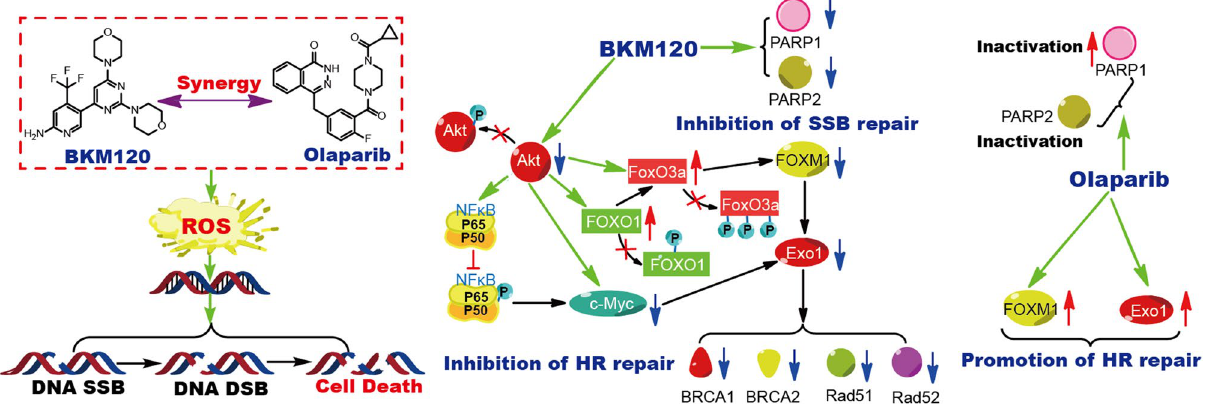
Figure 8. Mechanism for the synergistic effects of BKM120 and olaparib on the death of MDA-MB-231 cells. BKM120 directly induces DNA damage through increasing cellular ROS. Meanwhile, BKM120 downregulates the expression of PARP1 and PARP2 to synergy the inhibition of olaparib in the repair of DNA single damage. Moreover, BKM120 inhibits the HR repair of DNA double damage to sensitize cells to olaparib through regulation the PI3K/Akt/NFĸB/c-Myc pathway and PI3K/Akt/ /FOXM1/Exo1